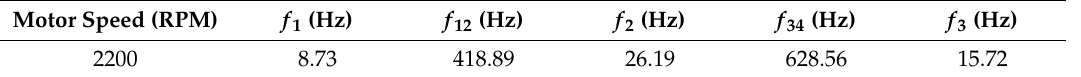
Table 2. Motor speed and characteristic frequencies of the gearbox.